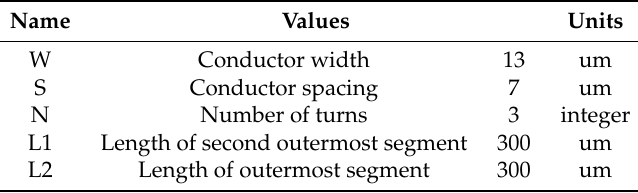
Figure 3. Geometrical layout of the planar spiral inductor. Table 1. Parameters of planar spiral inductor.